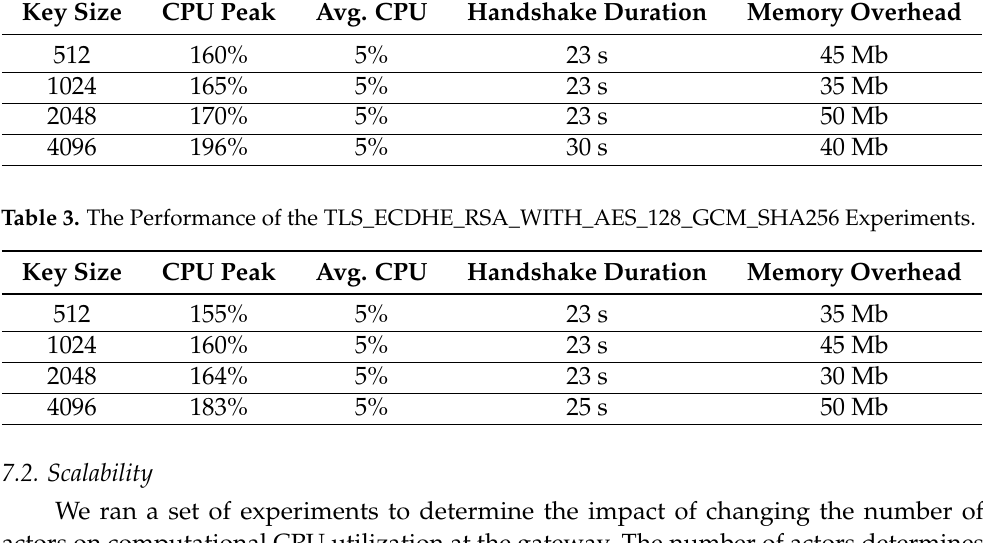
Table 2. The Performance of the TLS_DHE_RSA_WITH_AES_128_GCM_SHA256 Experiments. Key Size